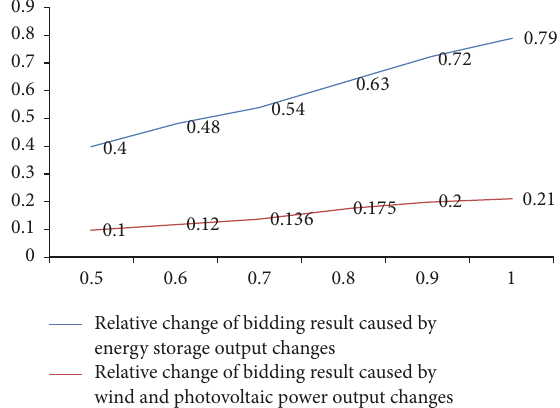
Figure 10: Effect on bidding result of energy storage and wind and photovoltaic power output